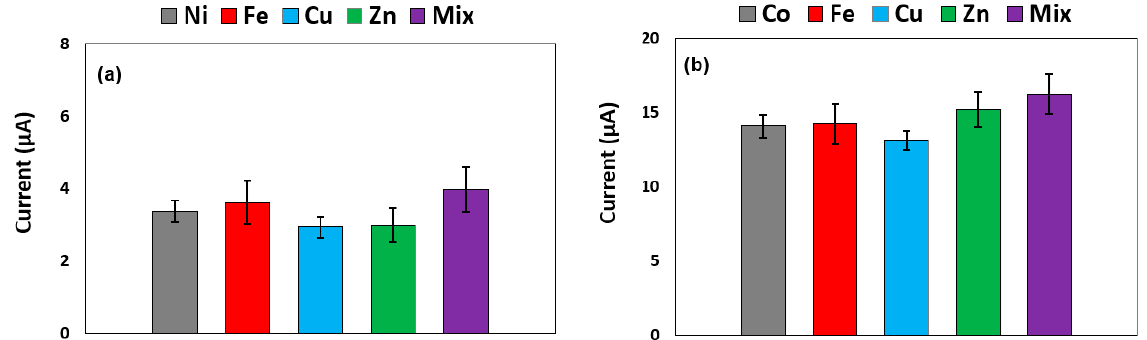
Figure 6. Possible interference of other metal ions on sensor performance for the detection of ( a ) and ( b ) Co(II). Ni(II) and Co(II) concentration was fixed at 35 µ g L − 1 . 70 µ g L − 1 of Fe(II), Zn(II), and Ni(II) and ( b ) Co(II). Ni(II) and Co(II) concentration was fixed at 35 μ g L − 1 . 70 μ g L − 1 of Fe(II), Zn(II), and Cu(II) were added to the standard solution individually, or a mixture of 70 μ g L − 1 of Fe(II), Cu(II) were added to the standard solution individually, or a mixture of 70 µ g L − 1 of Fe(II), Zn(II), Zn(II), and Cu(II) was added to the solution. and Cu(II) was added to the